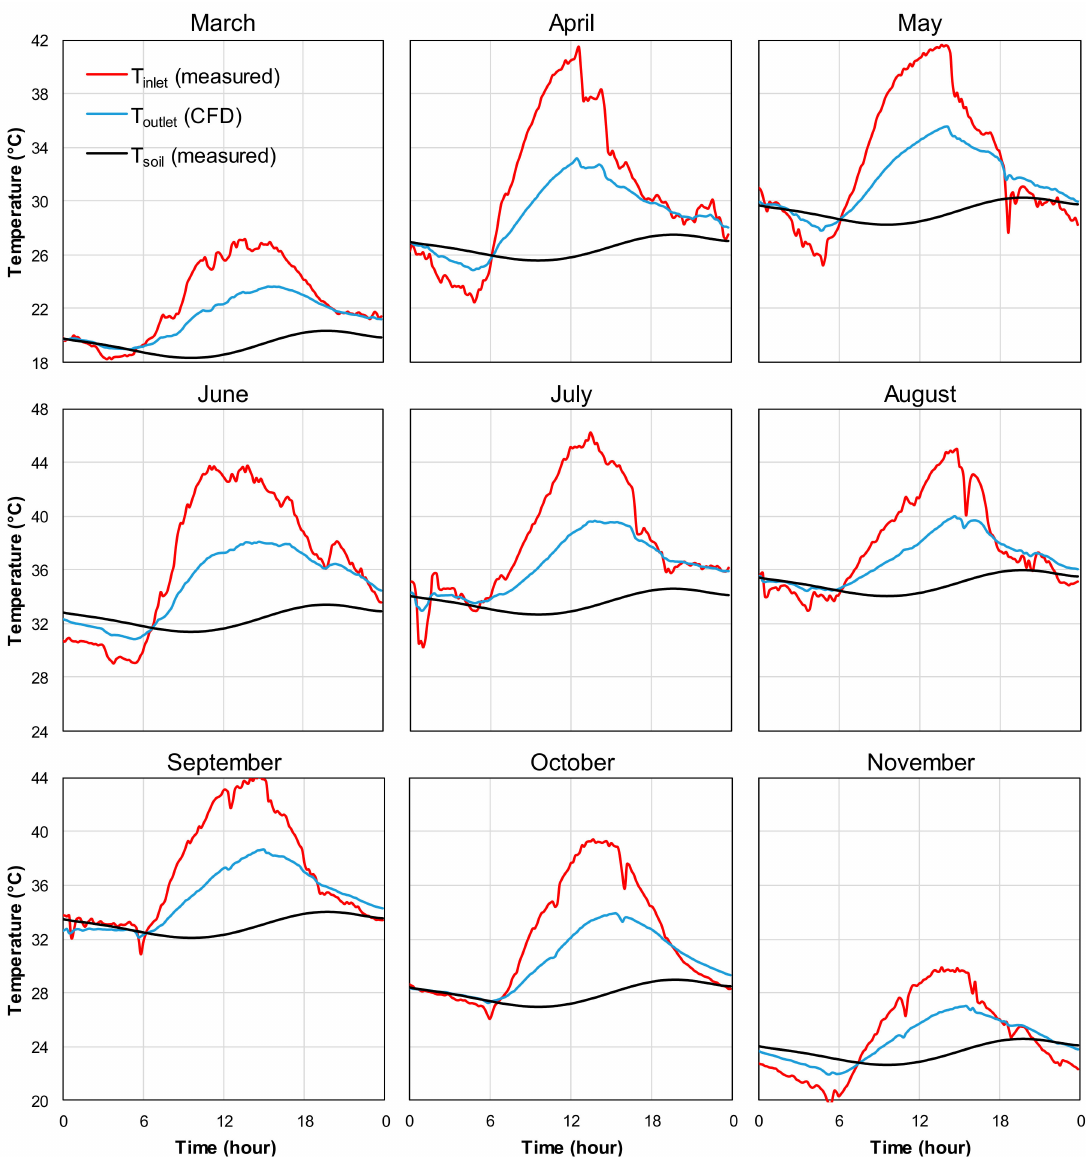
Figure 9. Predicted outlet temperature of the EAHE during typical days of March to November using experimentally measured ambient air temperature and soil temperature (320 mm